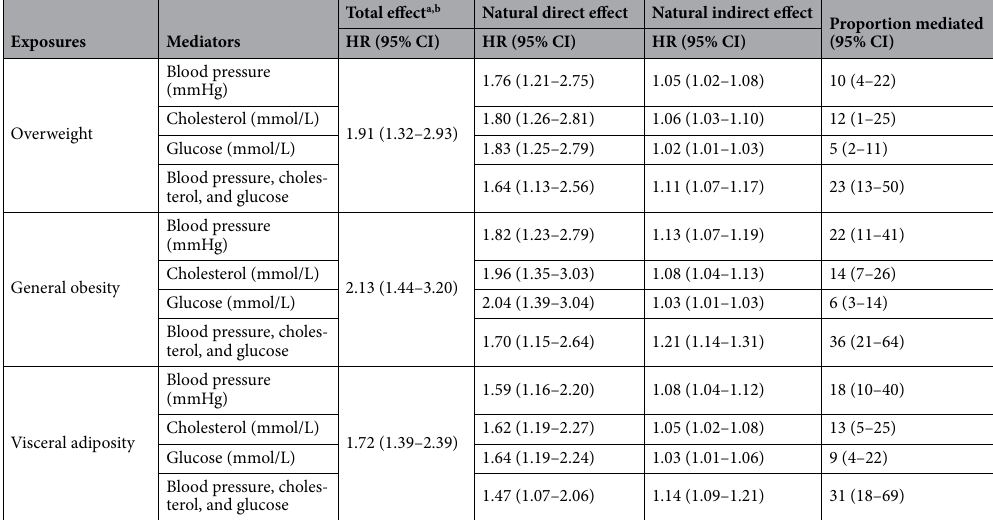
Table 4. Total, direct, and indirect effects of overweight and adiposity on cardiovascular diseases (CVDs) using a parametric method not considering exposure-mediator interaction in women. MI body mass index; CI confidence interval; HR hazard ratio; WC waist circumference. a Compared with normal-weight participants for general adiposity and WC < 90 cm as a reference for central adiposity. b All models were adjusted for age, gender, smoking, physical activity level, educational status, and family history of CVDs. c The direct, indirect, and total effects were estimated for each bootstrap resampling.